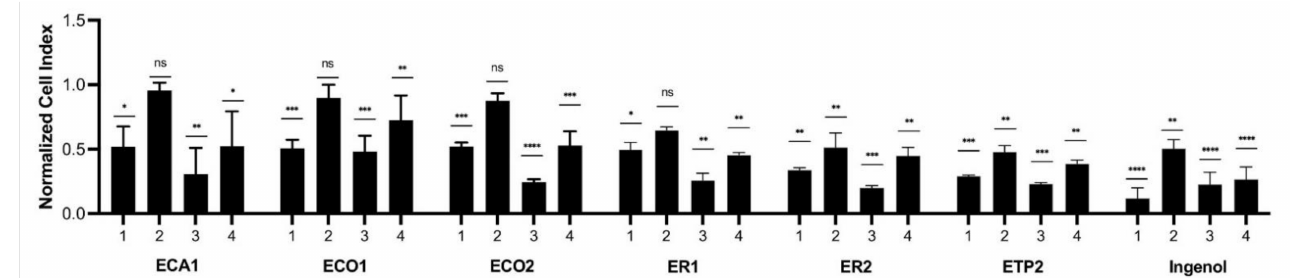
Figure 1. Inhibitory activity of different Euphorbia extracts against keratinocytes. ECA1: E. candelabrum n -hexane extract, ECO1: E. cotinifolia n -hexane extract, ECO2: E. cotinifolia CHCl 3 extract, ER1: E. ramipressa n -hexane extract, ER2: E. ramipressa CHCl 3 extract, ET1: E. trigona n -hexane extract, ET2: E. trigona CHCl 3 extract; 1: 5 µ g/mL, 24 h, 2: 0.5 µ g/mL, 24 h, 3: 5 µ g/mL, 48 h, 4: 0.5 µ g/mL, 48 h; * p < 0.05; ** p < 0.01; *** p < 0.001; **** p <